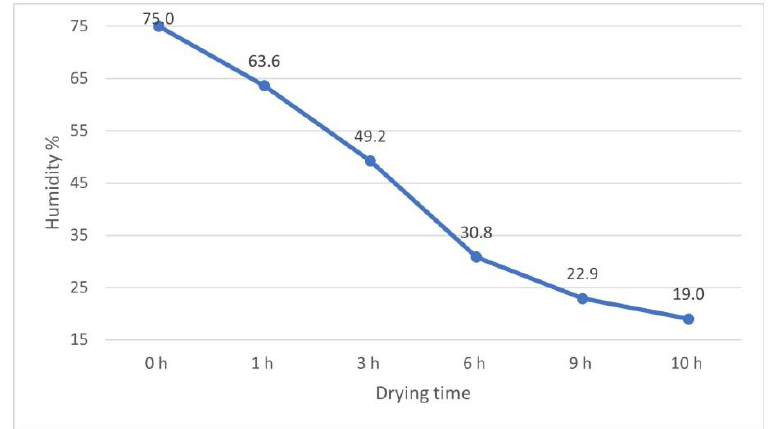
Figure 14. Drying curve—product moisture in chamber 4.